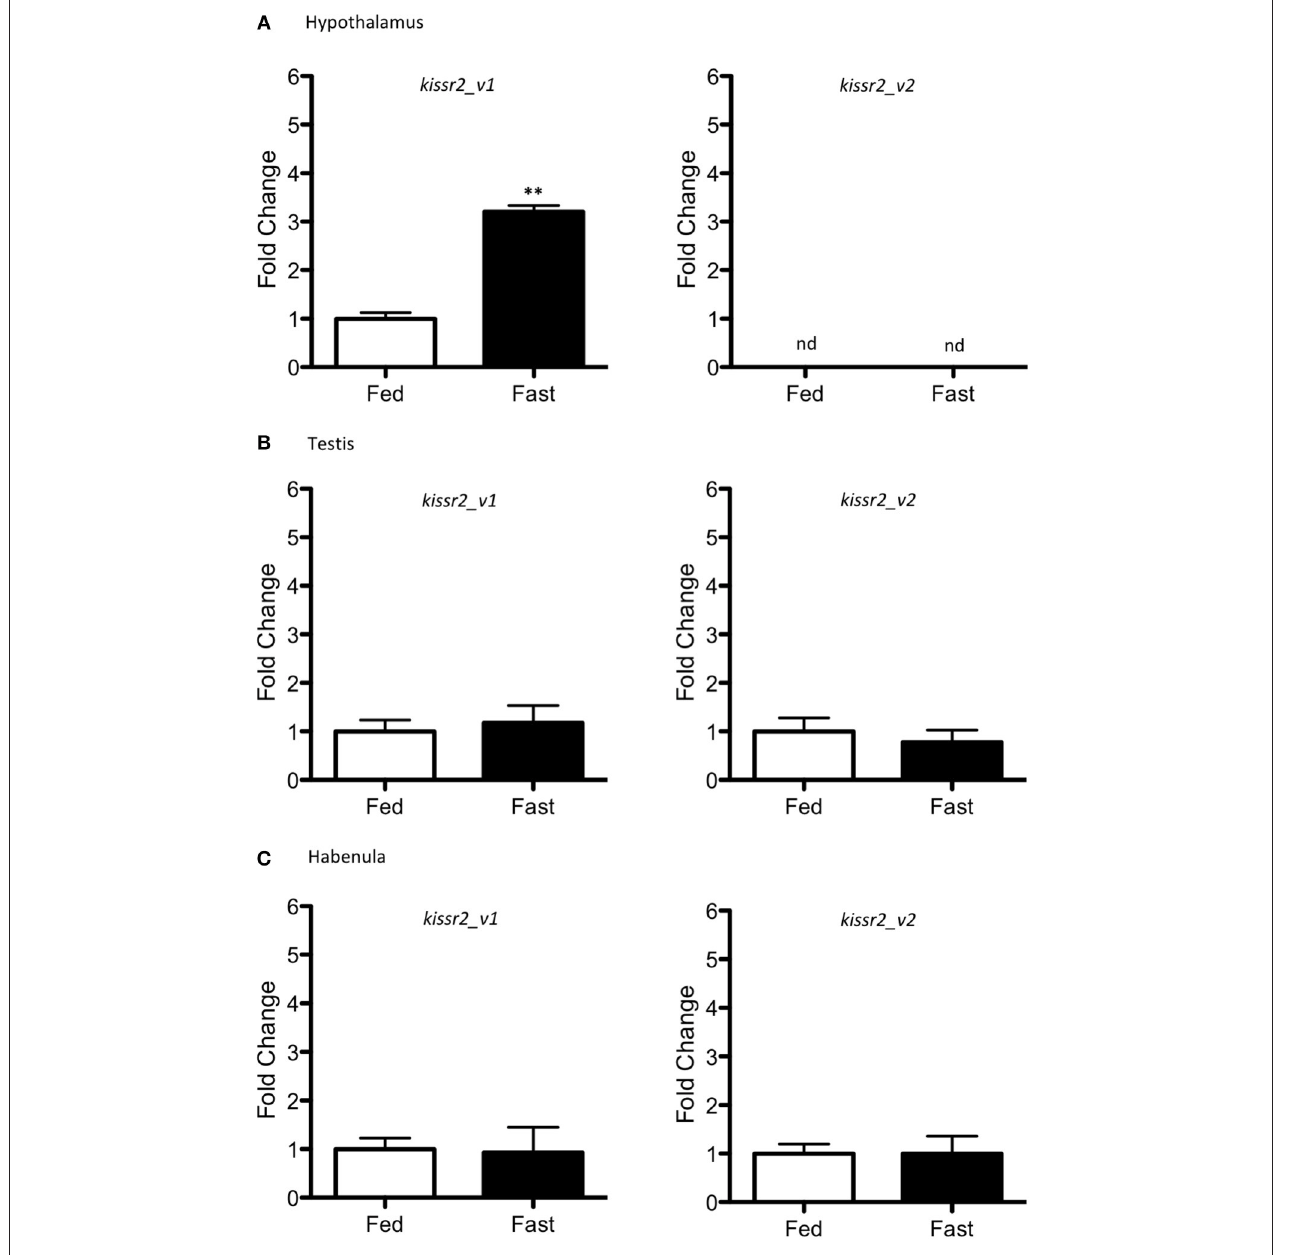
FIGURE 6 | Gene expression in different tissues of male pejerrey. Expression levels of kissr2_v1 and kissr2_v2 isoforms in the hypothalamus (A) , testis (B), and habenula (C) . Results are represented as fold change after data normalization against β -actin levels. Asterisks indicate statistically significant differences after the Student’s t -test. ** p < 0.01. n.d. non-detected. Data shown are expressed as mean ± S.E.M. ( n =